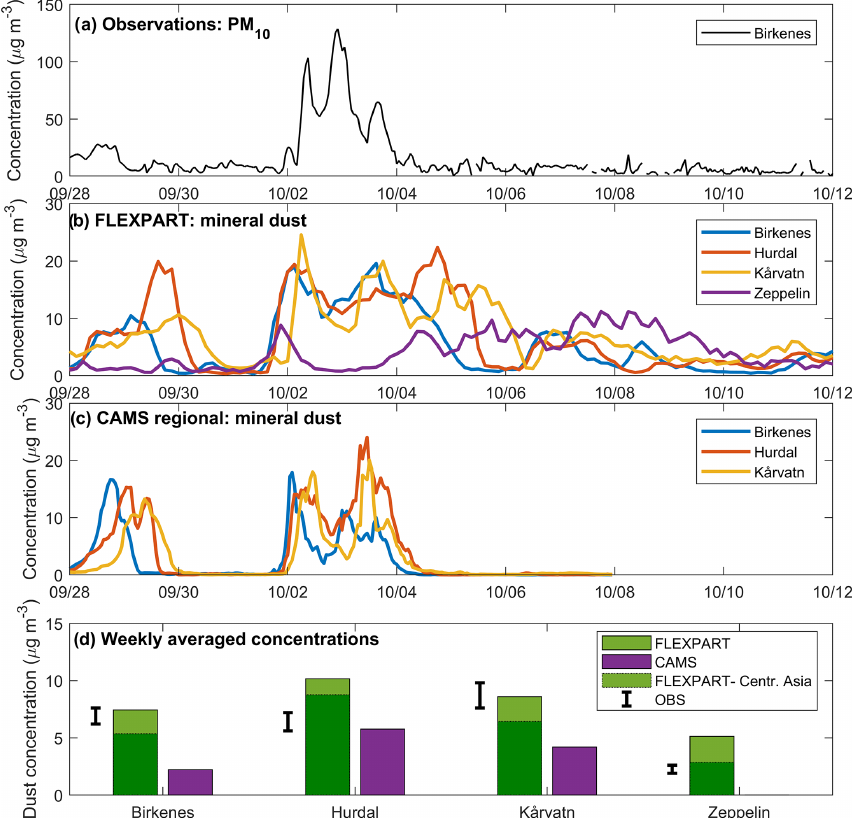
Figure 7. PM 10 concentrations observed at Birkenes (a) . Mineral dust surface concentrations as simulated with FLEXPART (b) and CAMS regional (c) at three stations in Norway and the remote station (outside CAMS domain). (d) Mean concentrations from simulations compared to observations from weekly samples for Birkenes (30 September–7 October 2020), Hurdal and Kårvatn (28 September–5 October 2020), and Zeppelin (2–12 October 2020). For FLEXPART estimates in panel (d) , light green colours indicate dust from global sources and dark green colours indicate the contribution of dust from Central Asia